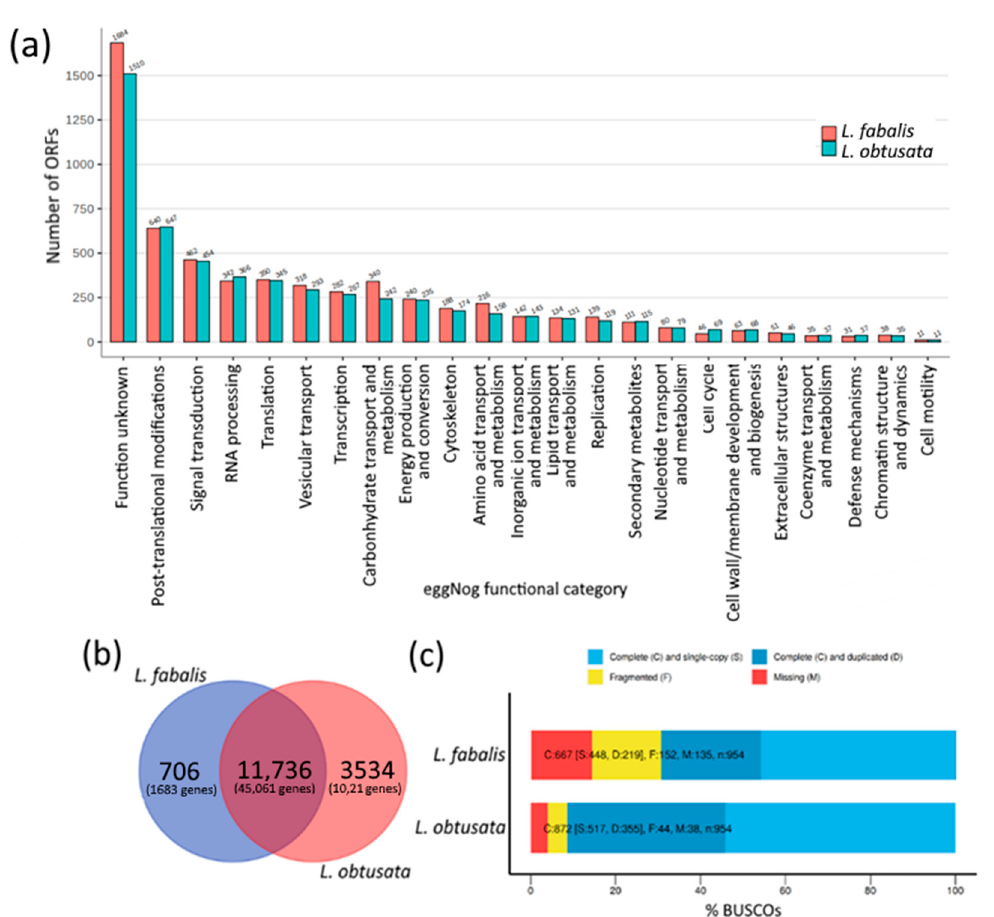
Figure 1. Results of de novo assembly of L. obtusata and L. fabalis oviduct transcriptomes. ( a ) Number of eggNOG annotated ORFs predicted in L. obtusata (blue) and L. fabalis (red) oviduct transcriptomes. ( b ) Venn diagram of overlapping and species-specific orthogroups with numbers of genes included in groups. ( c ) BUSCO analysis of L. obtusata and L. fabalis oviduct transcriptomes. C—complete genes [S—in single-copy, D—duplicated]; F—fragmented genes; M—missing genes; n—total number of genes.